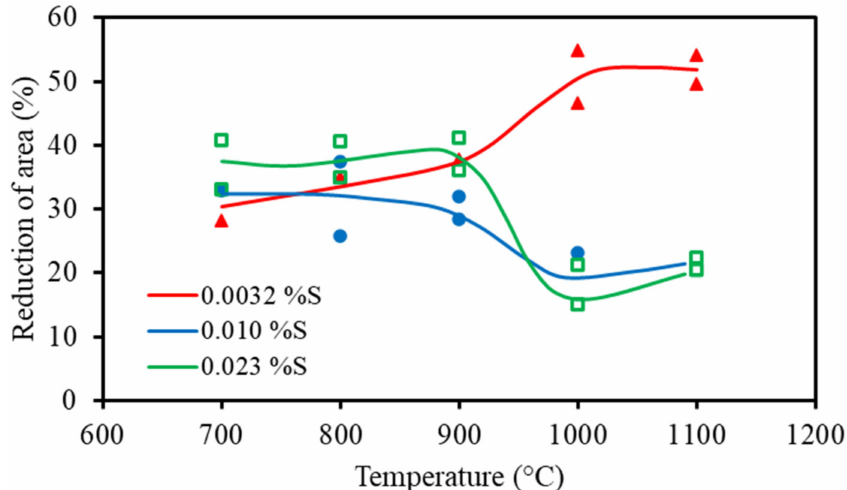
Figure 19. Hot ductility curves for three TWIP steels having 0.003, 0.01 and 0.023% S with base composition: 0.6% C, 18.3% Mn, 1.5% Al and 0.009% N